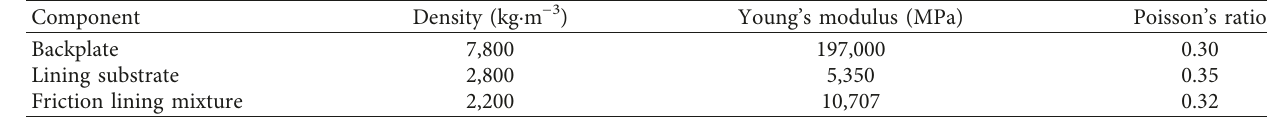
Table 4: Material properties of each component of brake pad.